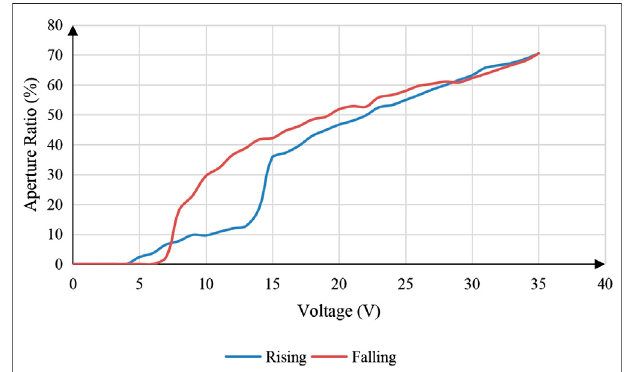
FIGURE 13 | The hysteresis curve of an EWD driven by the multi waveform.